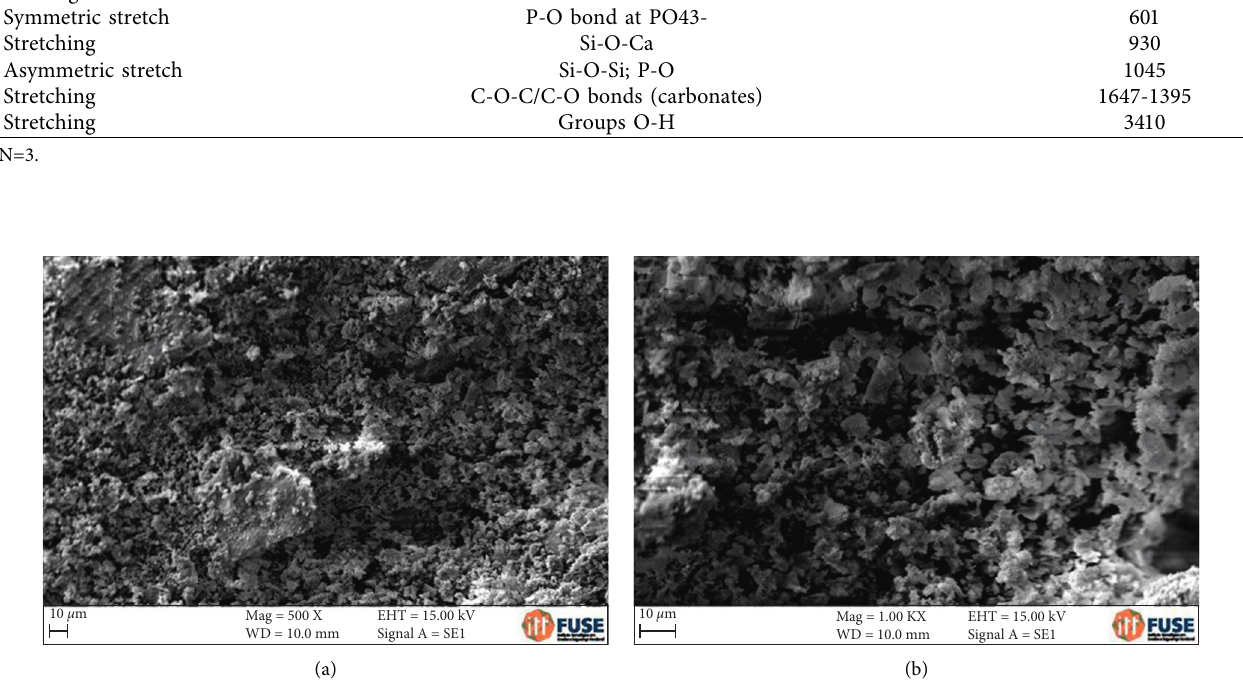
Figure 2: Representative SEM photomicrographs of the composite exhibiting a porous structure and absence of spicules, as well as pore size variations ((a) 500X magnification and (b) 1000X magnification).